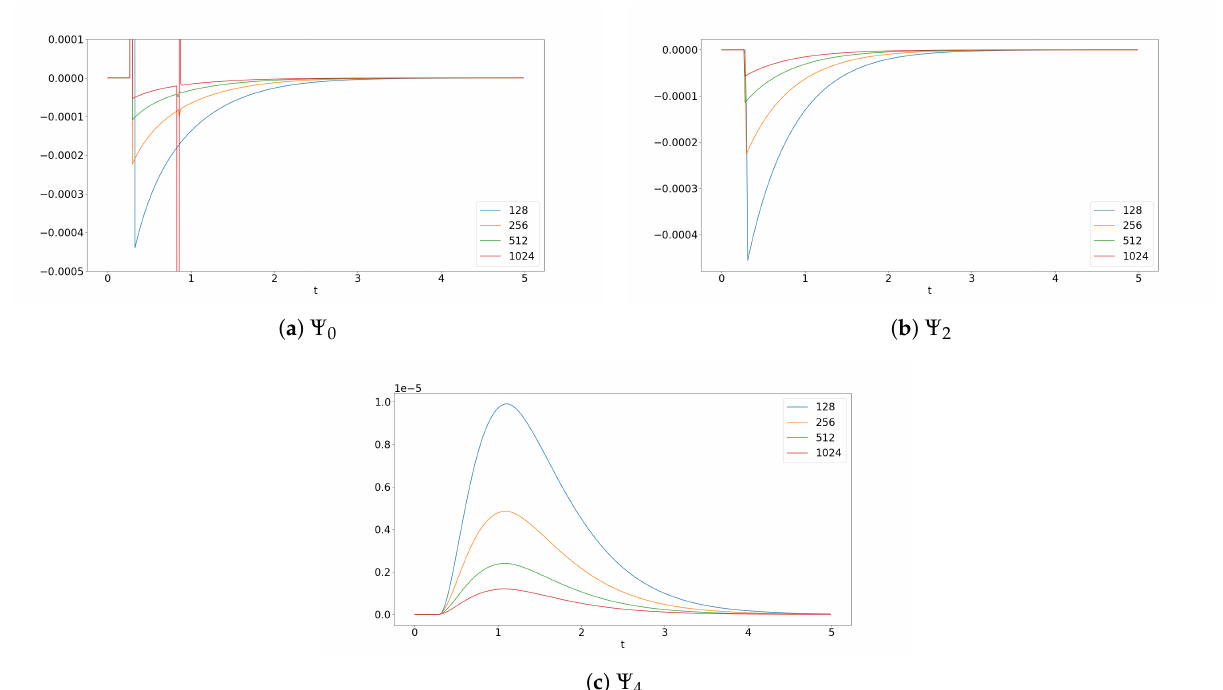
Figure 8. Plots along z = 0 of Ψ 0 , Ψ 2 and Ψ 4 as a → ∞ with λ = 0.6. Figure 9 shows the Ψ 2 and Ψ 4 components along the right boundary for λ = 0.6 and λ = 1.2, where a future singularity is formed when λ = 0.6.